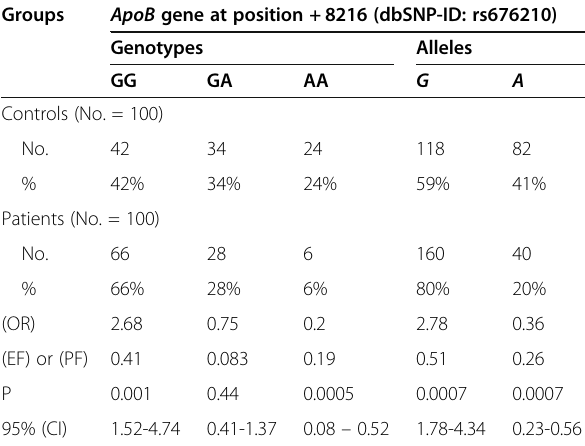
Table 4 Genotype and allele frequencies of ApoB gene polymorphism rs676210 between patient and control groups Groups